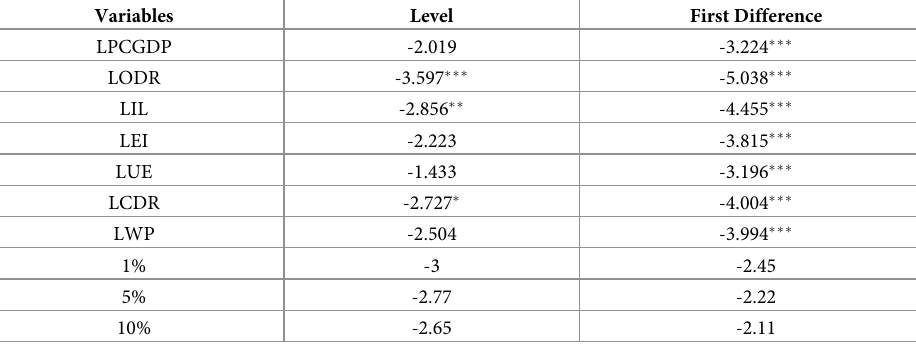
Table 11. CIPS unit root test of western region of China.